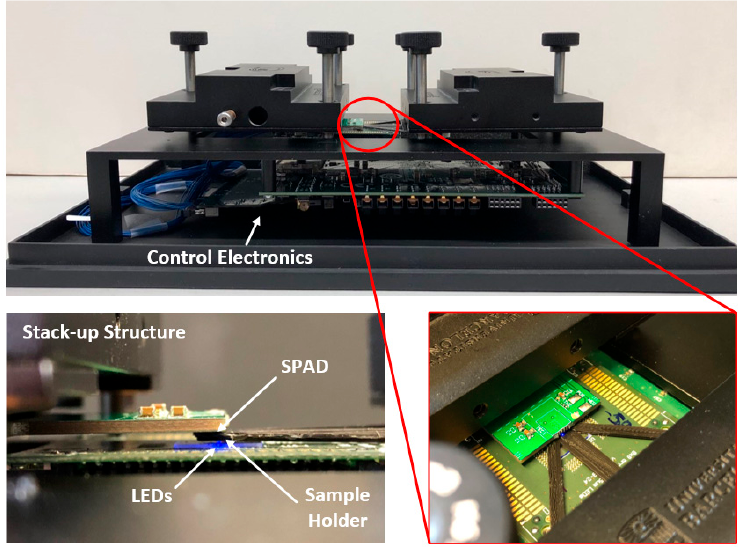
Figure 7. Setup of the first-generation microscope with a detail of the stack-up composed by the Led1 chip, sample/sample holder, and CMOS SPAD camera. chip, sample/sample holder, and CMOS SPAD camera.